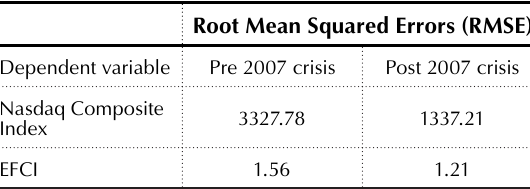
Table 9. Forecast evaluation